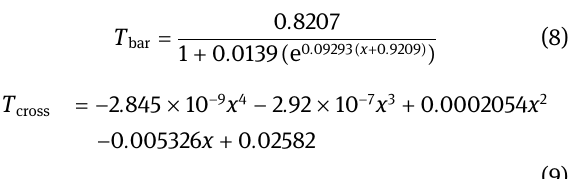
curve fi tting the data points in Figure 4D and 6D. The NLAF transmission, T NLAF , as a function of fl uence, F , is given by Eq. (7). The weights (P 3 A) transmission for the bar, T bar , and cross, T cross , ports as a function of the amorphized Sb length, x , along the coupler are given in Eqs. (8) and (9), respectively. As can be seen, sigmoid and polynomial func- tions gave the best least-squares fi tting results.